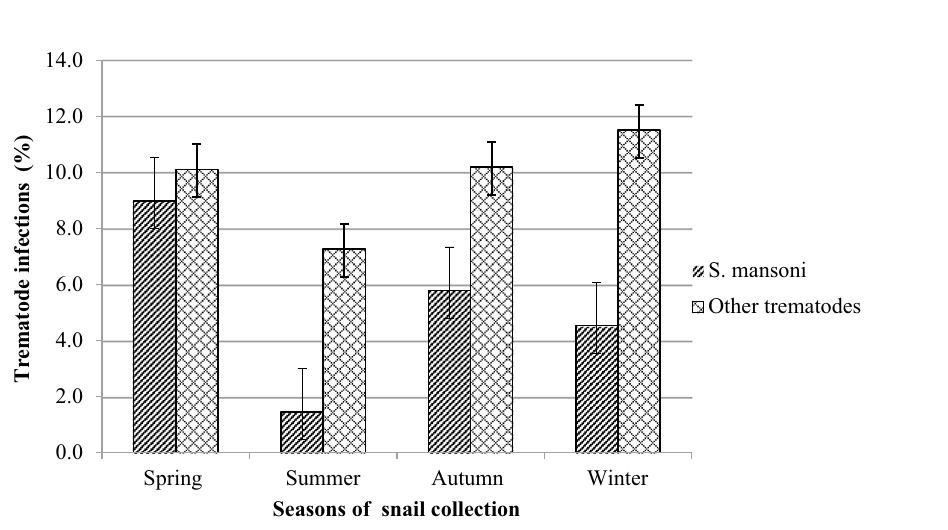
Figure 8. Seasonal variations of S. mansoni and other trematodes